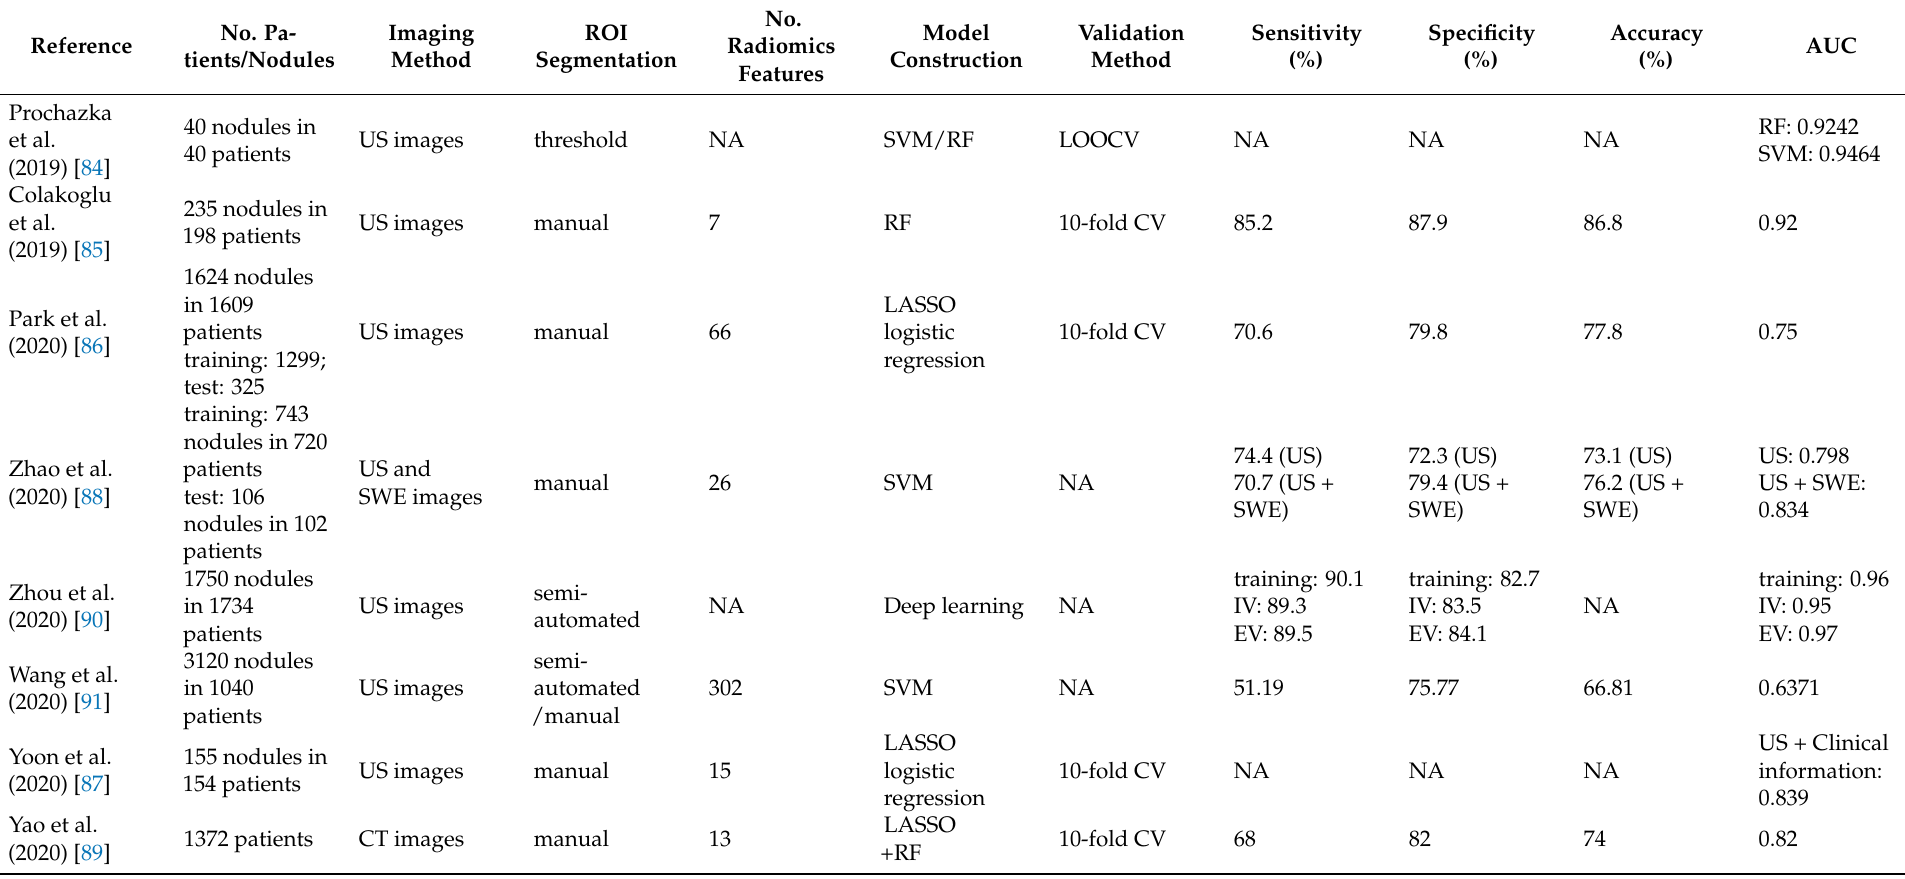
Table 2. Studies used radiomics to differentiate malignant from benign